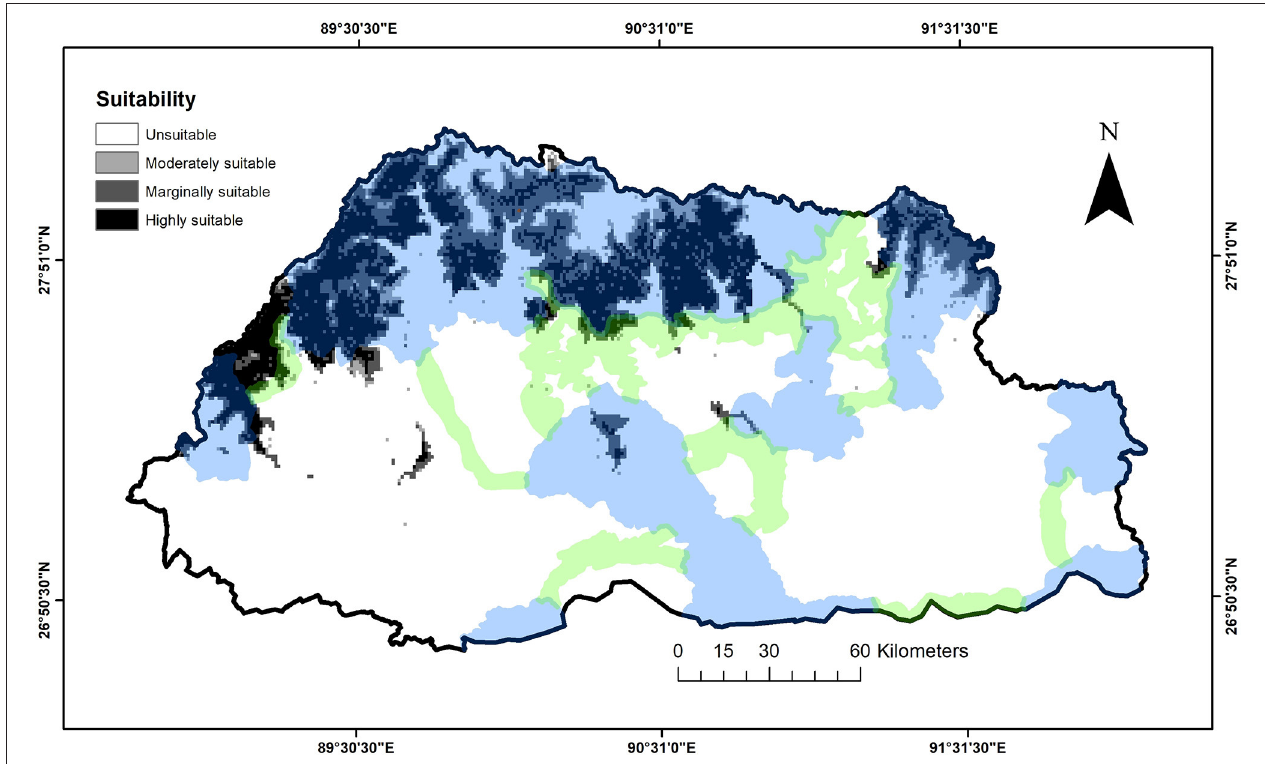
FIGURE 3 | Extent of unsuitable and marginally-to-highly suitable habitats for snow leopards in Bhutan, as predicted by an ensemble of Species Distribution Models.